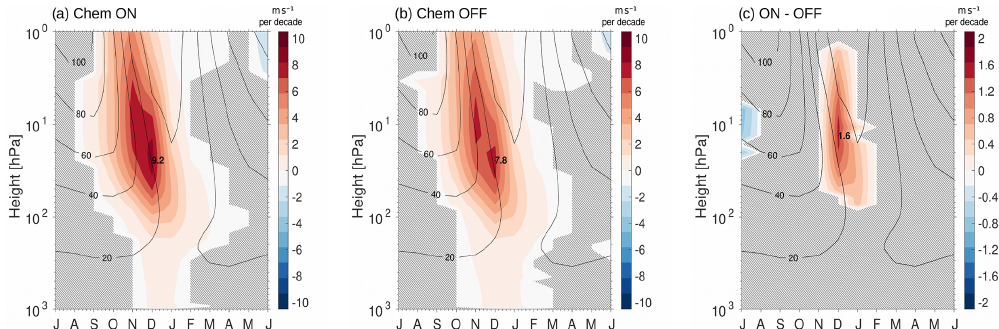
Figure 8. Zonal mean zonal wind trend (60–70 ◦ S) in meters per second per decade as function of height for the time period 1969–1998 (shading) for the ensemble mean of (a) Chem ON and (b) Chem OFF, as well as for (c) the differences (shading) between the simulations. The particular climatologies (contours) are represented for the same period with an interval of 20ms − 1 . Statistically insignificant regions are hatched at the 5% level based on a Mann–Kendall test.